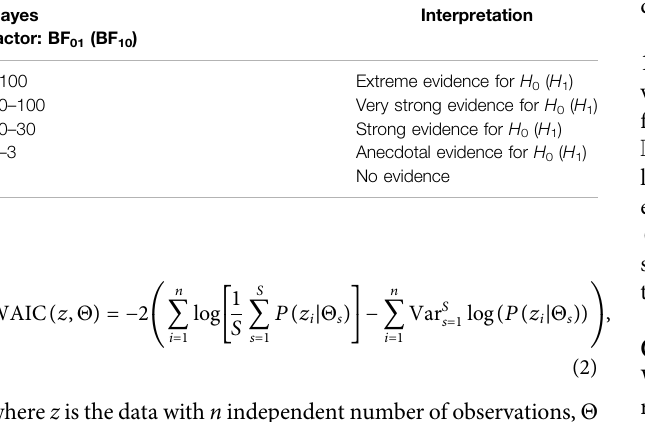
TABLE 4 | Bayes factor interpretation. Bayes factor: BF 01 (BF 10 )